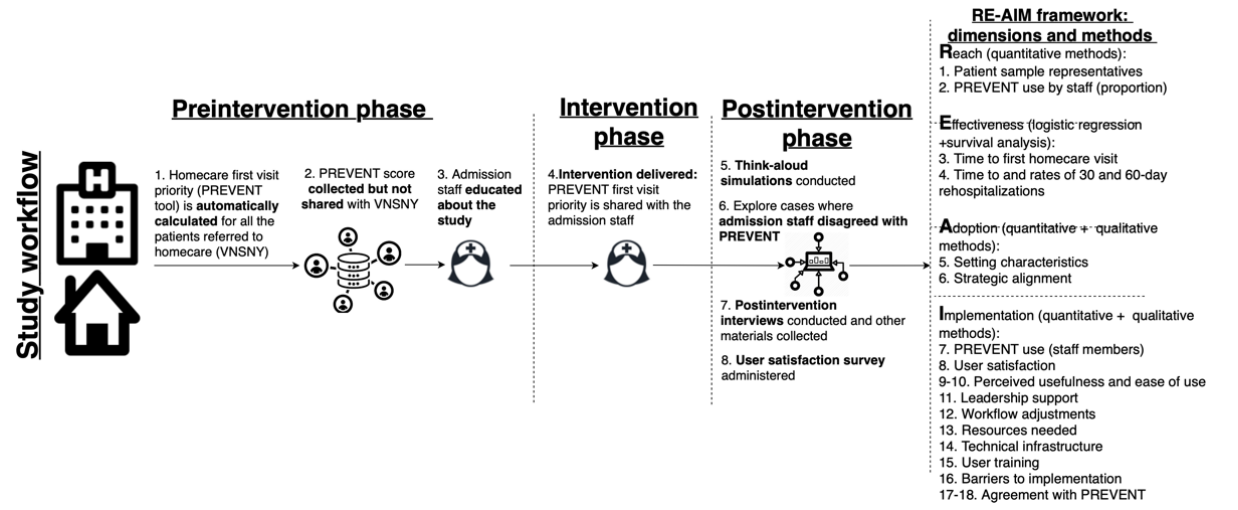
Figure 1. Study workflow and design. PREVENT: Priority for the First Nursing Visit Tool; RE-AIM: Reach, Effective-ness, Adoption, Implementation, and Maintenance; VNSNY: Visiting Nurse Service of New